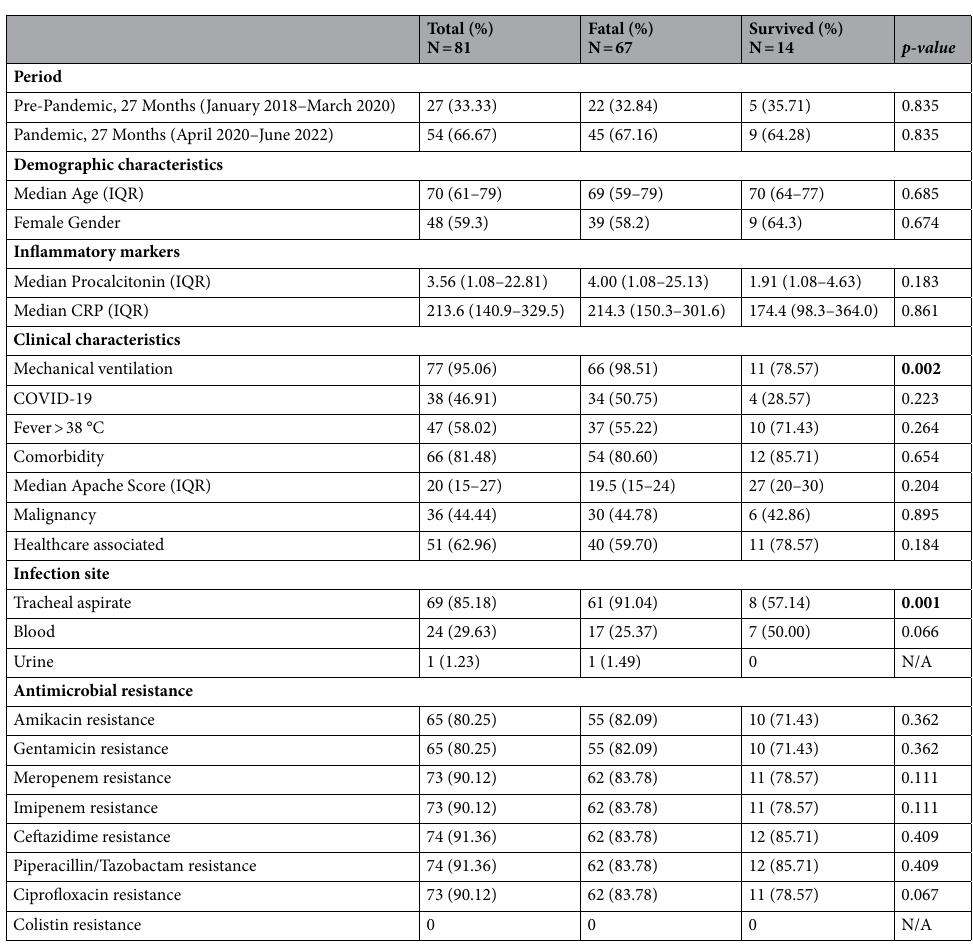
Table 2. Demographic and clinical characteristics of patients with A. baumannii infection. Significant values are in